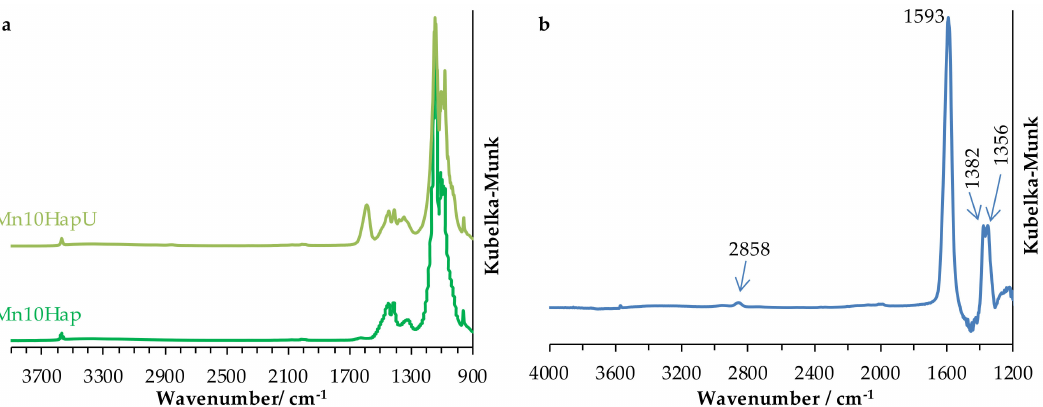
Figure 10. ( a ) Di ff use Reflectance Infrared Fourier Transform spectroscopy (DRIFT) spectra of Mn10Hap sample before and after the catalytic test (Mn10HapU) and ( b ) Di ff erence between the two recorded